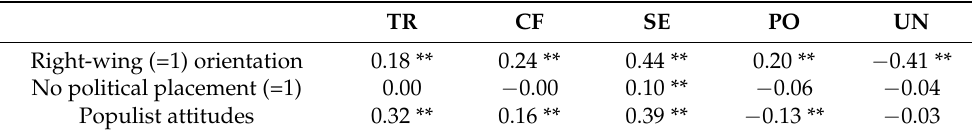
Table 2. Policy support and personal values: a correlation analysis. TR CF SE PO UN Right-wing (=1) orientation 0.18 ** 0.24 ** 0.44 ** 0.20 ** − 0.41 ** No political placement (=1) 0.00 − 0.00 0.10 ** − 0.06 − 0.04 Populist attitudes 0.32 ** 0.16 ** 0.39 ** − 0.13 ** − 0.03 ** p < 0.001; * p < 0.05. Note: TR: tradition; CF conformity; SE: security; PO: power; UN: